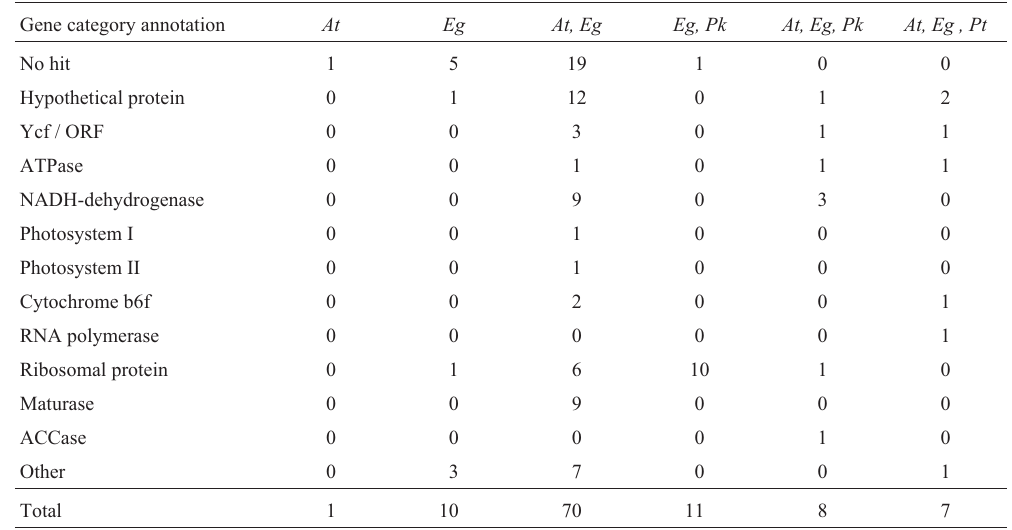
Table 3 - Distribution of putative annotation of reads matched to the four query species’ plastome ( Arabidopsis thaliana , Eucalyptus globulus , Pinus thunbergii , or Pinus koraiensis .). Gene category annotation